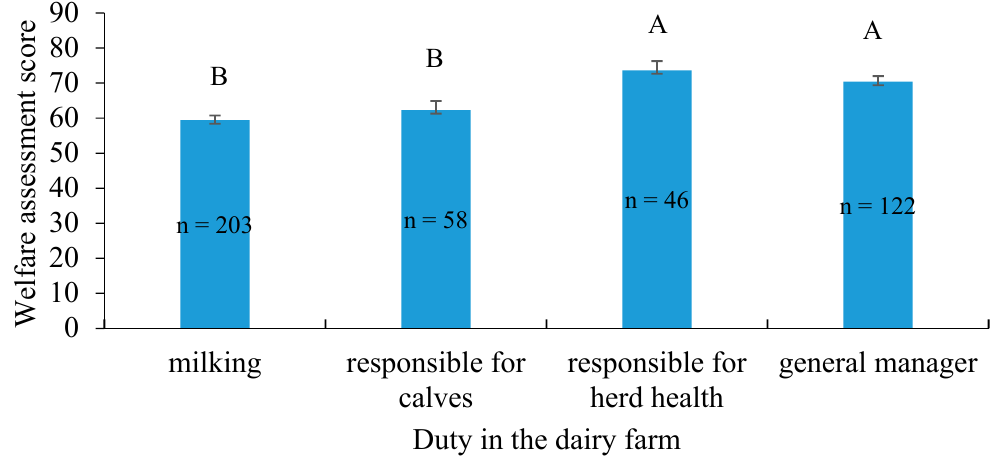
Figure 4. Welfare assessment score (LS mean ± SE) for individuals with different duties on the dairy farm ( n = 429; p = 0.02). Letters “A” and “B” signify statistical differences between groups.